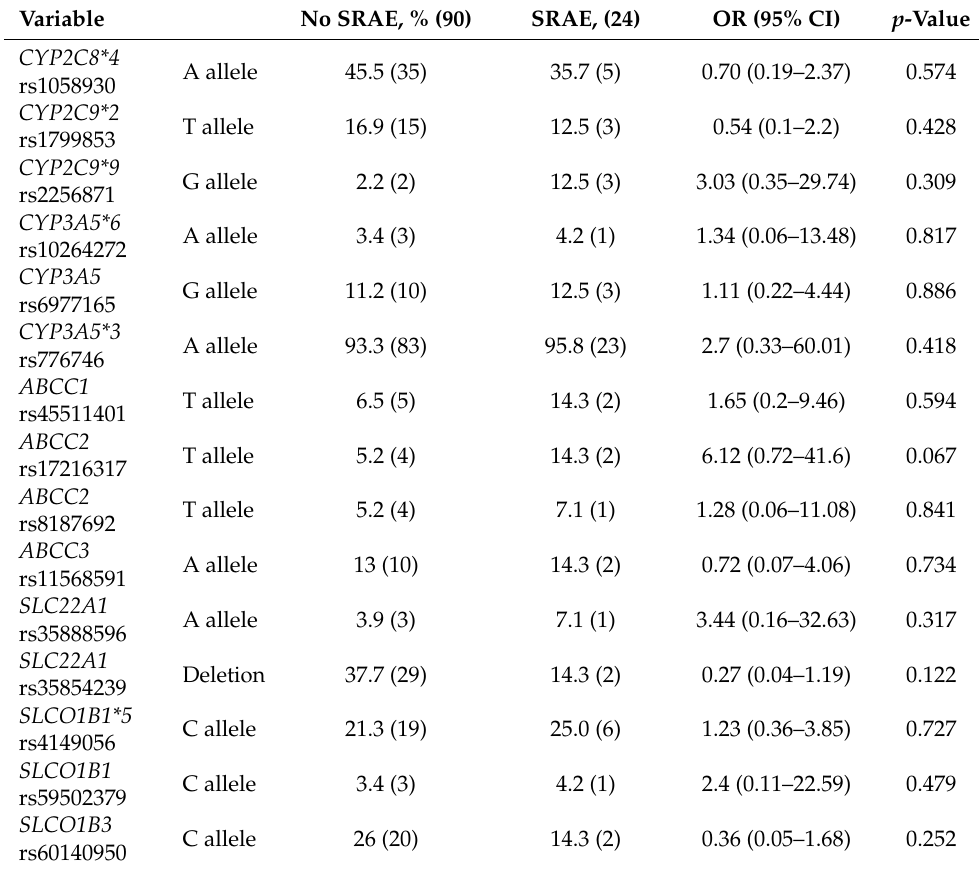
Table 6. Association of deleterious variants (MAF > 1.0%) in PK-related genes with SRAE in FH patients: Multivariate logistic regression